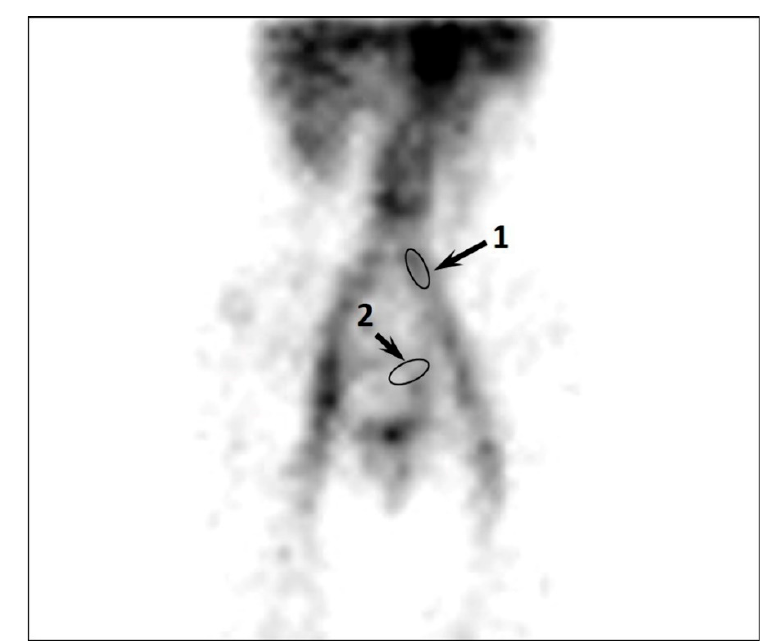
Figure 3. SPECT imaging of the pelvic veins of patient K. with asymptomatic PeVD. Low accumulation of labeled RBCs in the parametrial and uterine veins. The arrows indicate the regions of interest: 1, “common iliac vein; 2, “parametrial” veins. C PVC = 0.8.